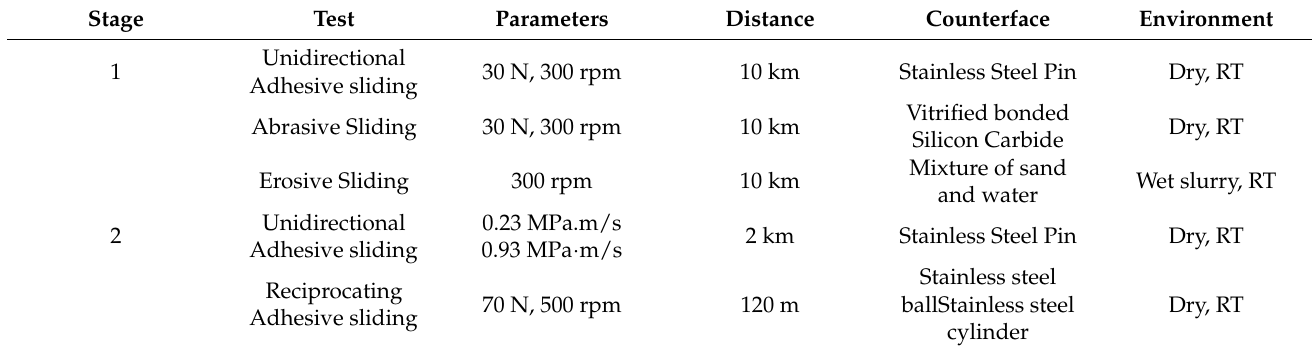
Table 3. Summary of operating parameters for friction and wear